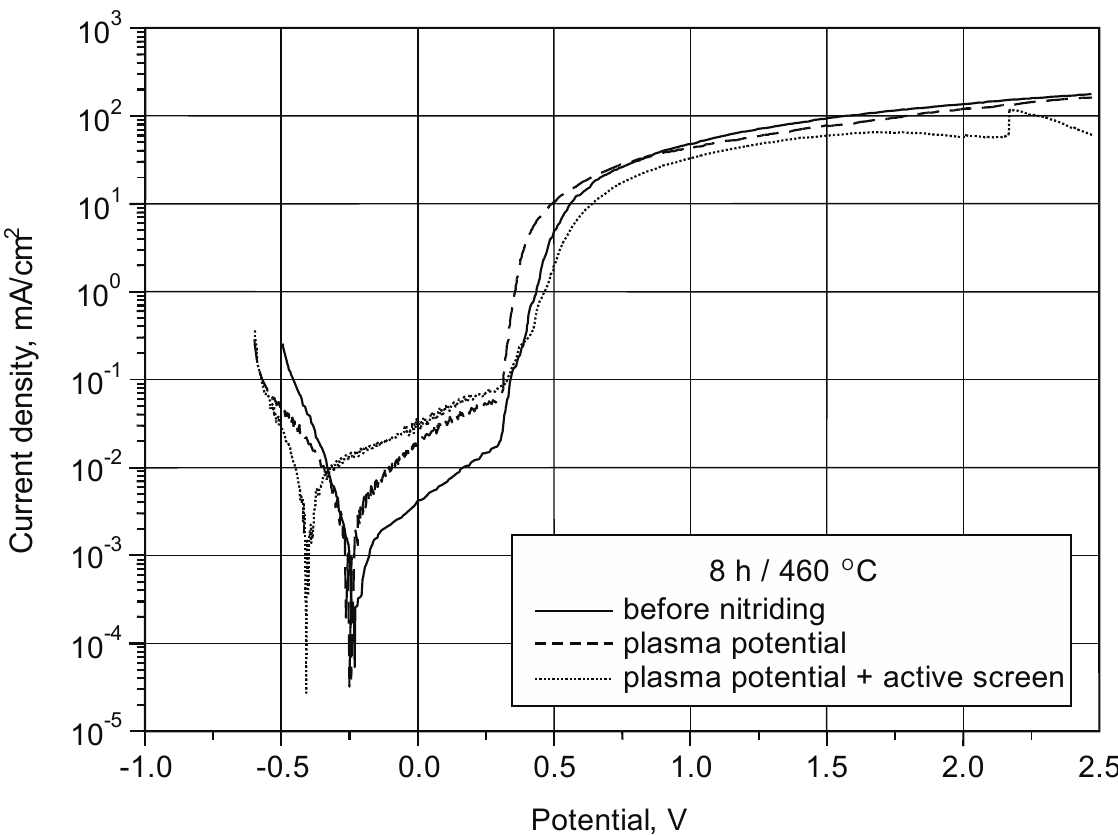
Figure 9. Image of nitrided 316L steel substrate, after potentiodynamic tests: ( a ) before nitriding, ( b ) plasma potential, ( c ) plasma potential + active screen.